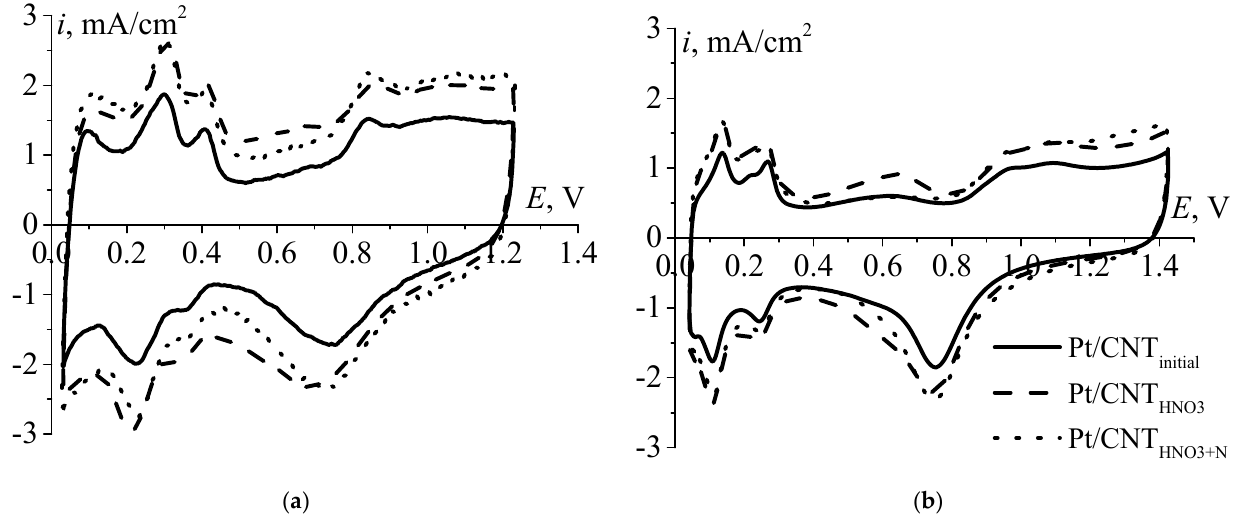
Figure 2. Cyclic voltammetry (CV) on Pt catalysts: ( a ) 0.1 M KOH; ( b ) 0.5 M H 2 SO 4 . O 2 ; the potential scan rate is 100 mV/s; m kat = 0.15 mg/cm 2 .